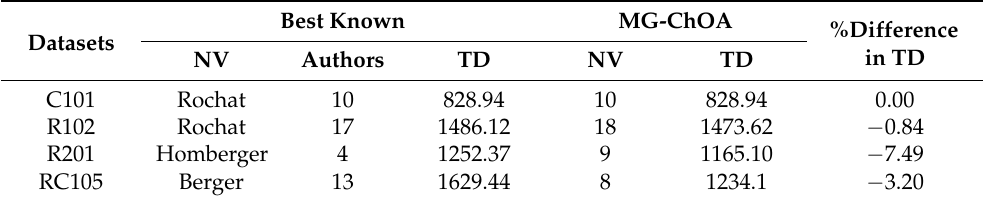
Table 3. The comparison of the results for four Solomon datasets.